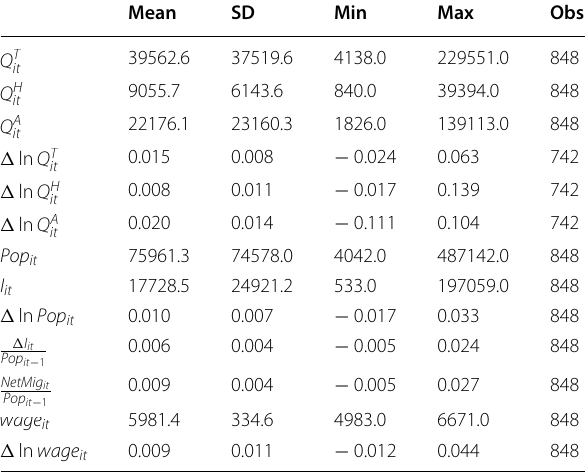
Table 13 Descriptive statistics at MS-level, 2009–2016. Source: Own calculations based on data from Federal Statistical